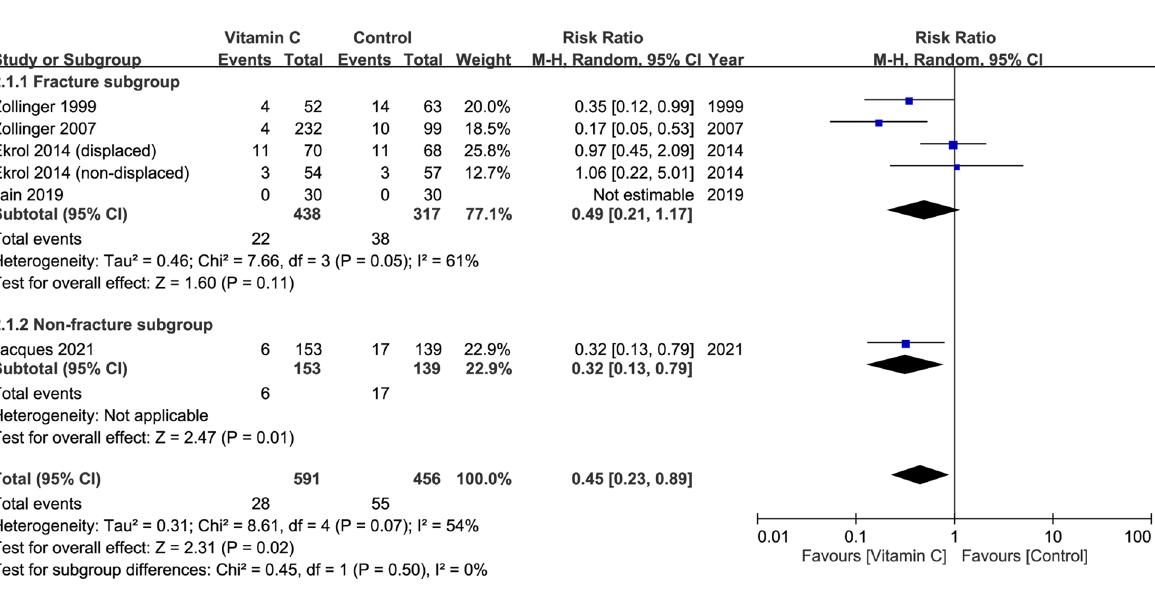
Figure 6. Forest plot for the comparison of risk of complex regional pain syndrome I between vitamin C (dosage ≥ 500 mg daily) and placebo groups at follow-up of 12 months. CI, confidence interval; M–H, Mantel–